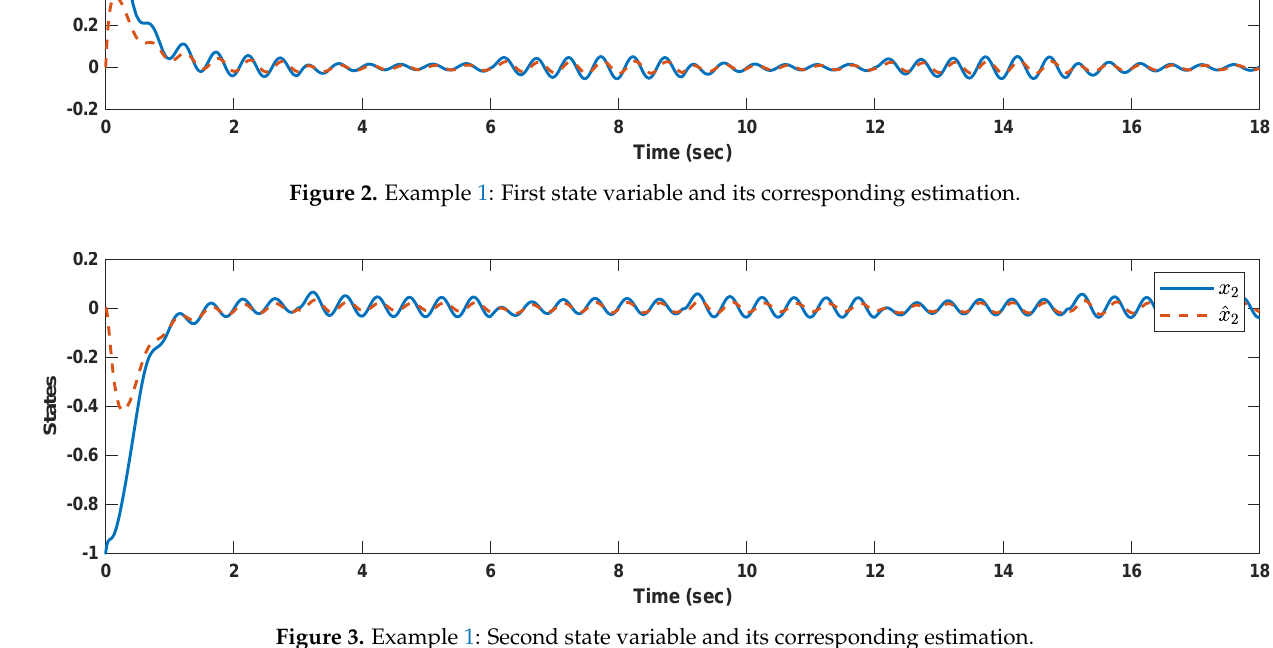
Figure 3. Example 1: Second state variable and its corresponding estimation.